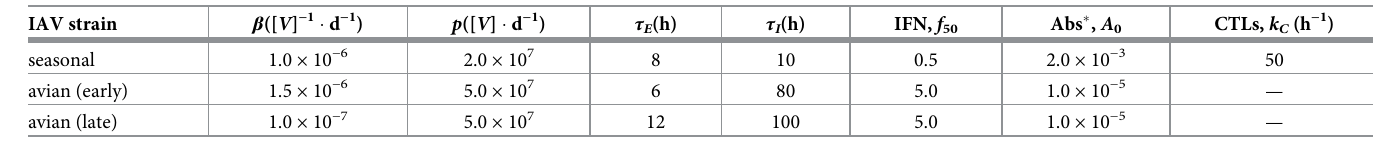
Table 2. Parameter values used to reproduce the IAV infection kinetics in Fig